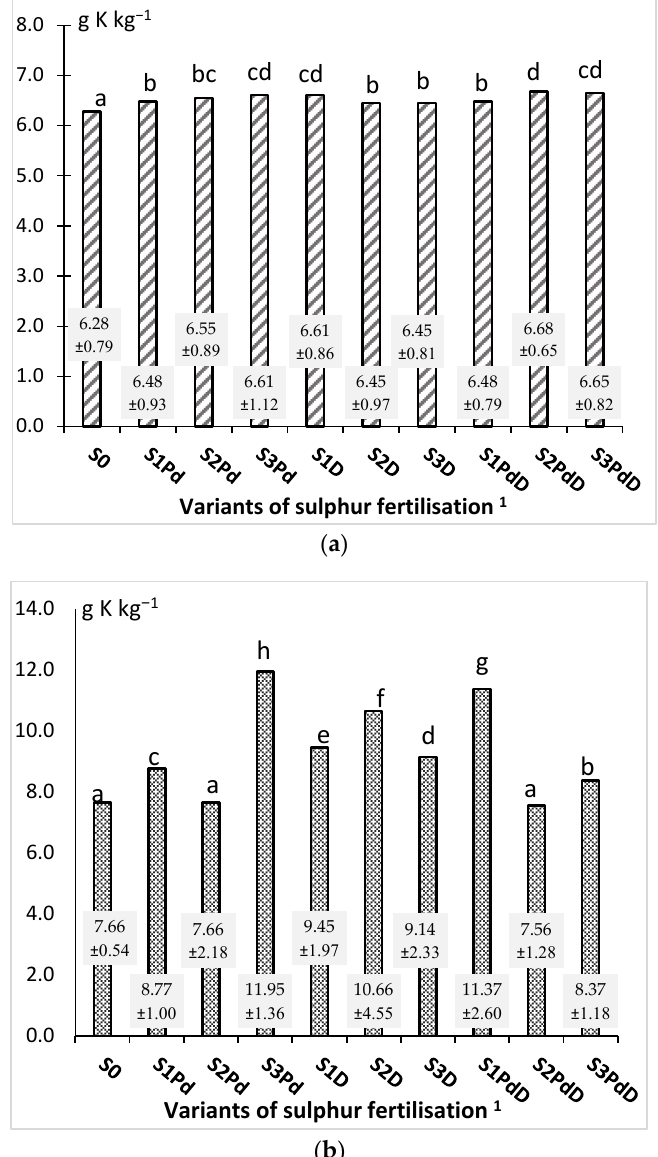
Figure 8. ( a ) Potassium content in the rape seeds on average for variants of sulphur fertilisation; ( b ) Potassium content in the rape straw on average for variants of sulphur fertilisation. 1 See Table 2; Means followed by the same letter are not statistically different at the α = 0.05 level. ± —standard deviation.